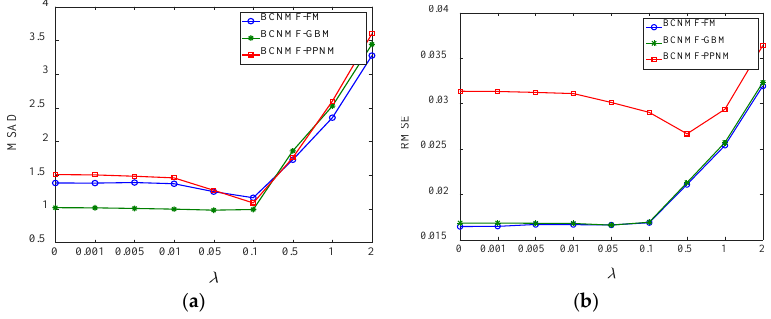
Figure 11. The unmixing accuracies of BCNMF when regularization parameter λ changes: ( a ) MSADs; ( b ) RMSEs.